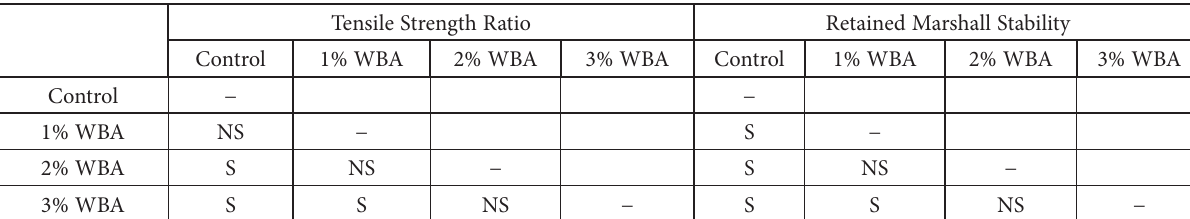
Table 10. Statistical analysis results of Tensile Strength Ratio and retained Marshall Stability (irrespective of mixing